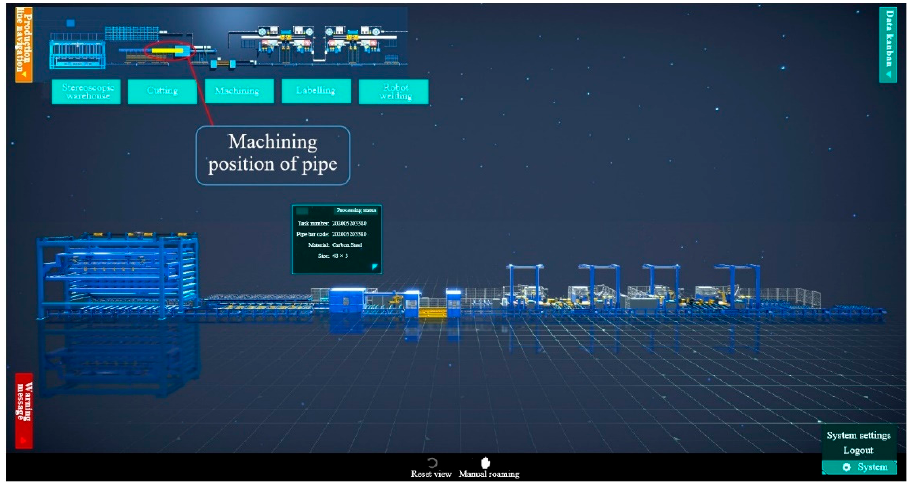
Figure 8. The operation interface of digital twin system in pipe machining production line.